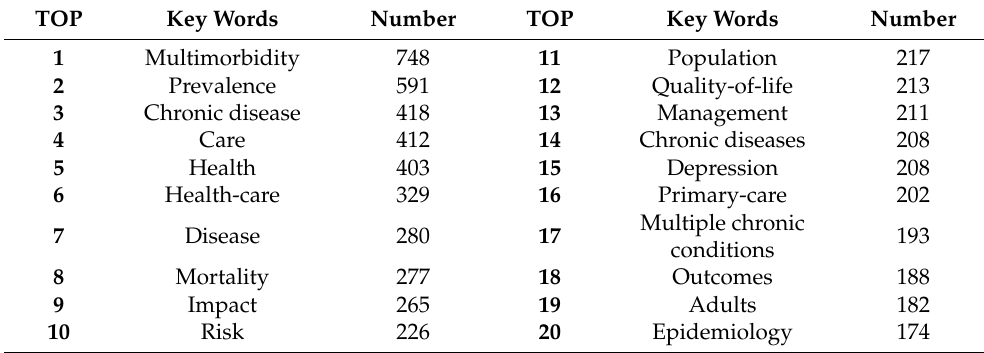
Table 3. Top 20 Frequency of Core Keyword in English Articles.